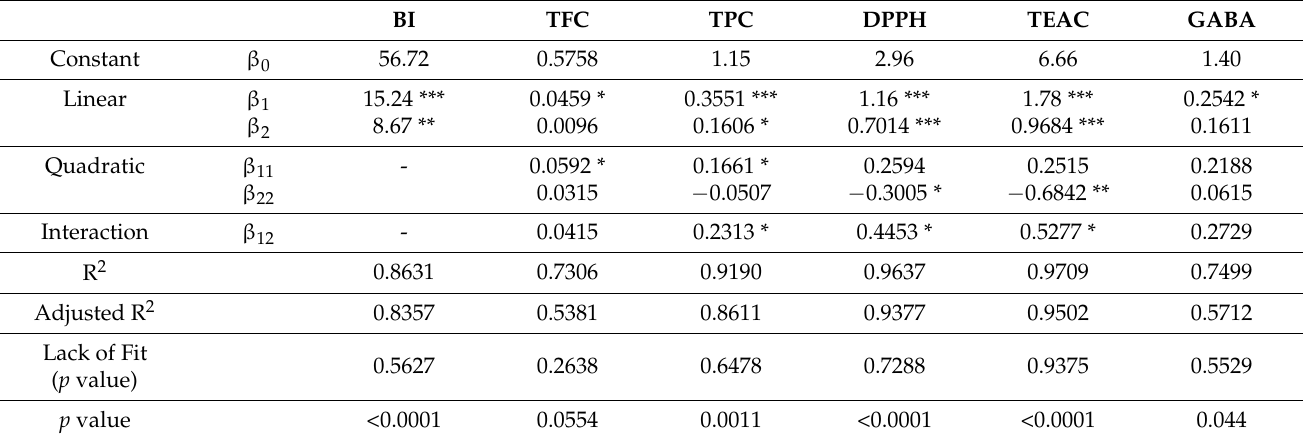
Table 4. Analysis of variance (ANOVA) for the response